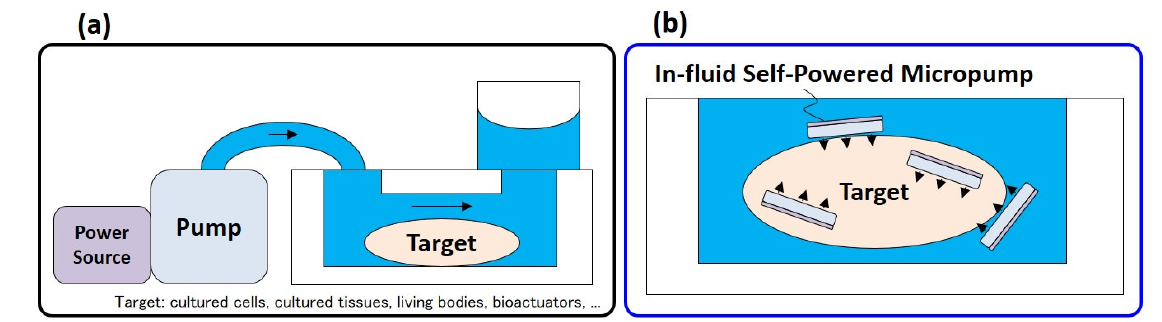
Figure 1. Perfusion methods. ( a ) Conventional perfusion with an external pump. ( b ) Perfusion via in-fluid self-powered